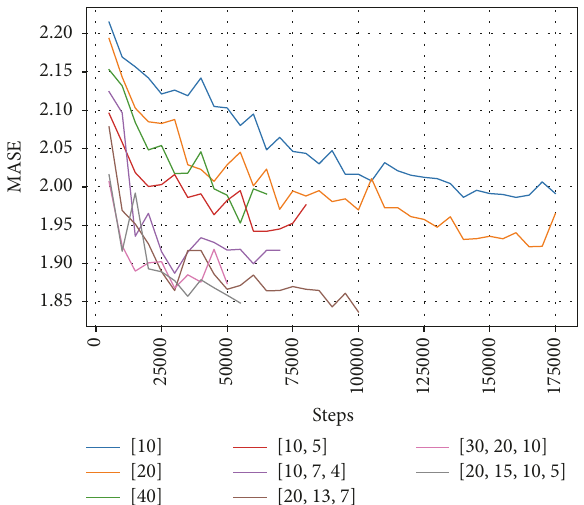
Figure 8: Trend in MASE for different FNNs with sigmoid activa- tion function and 6 h historical input